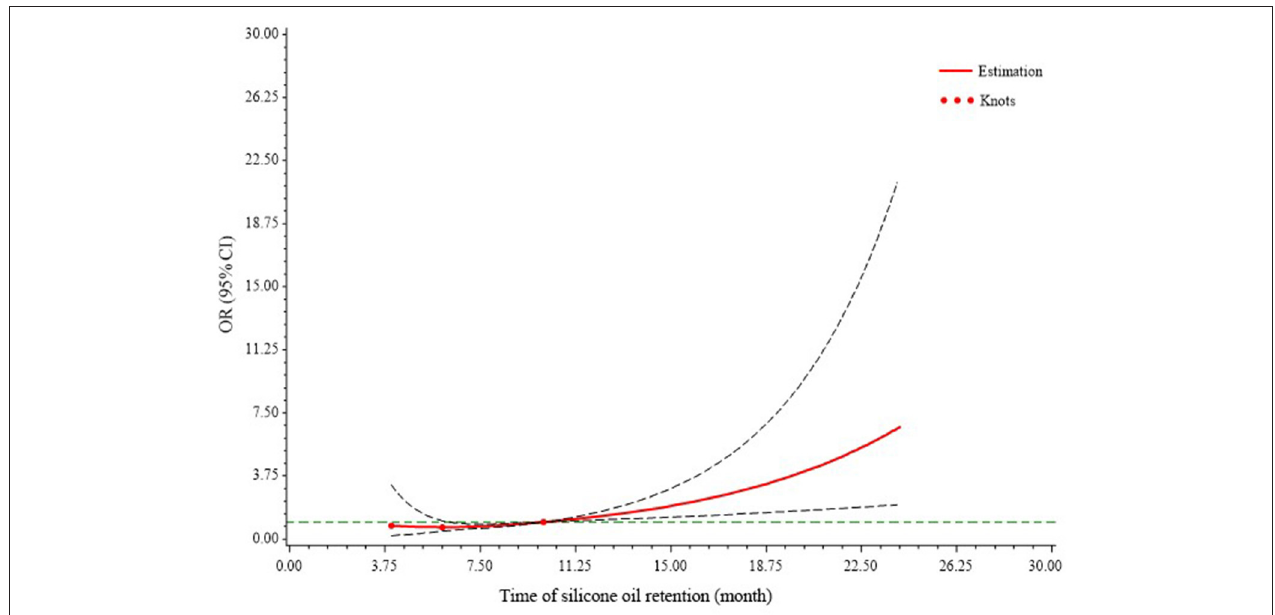
FIGURE 2 | Association between band keratopathy and silicone oil retention time. Restricted cubic splines with three knots at the 25th, 50th, and 75th centiles were used to model the association between band keratopathy and silicone oil retention time. This model was adjusted for intraocular pressure, sex, diagnosis, zone of injury, and iris status. The 95% confidence intervals are indicated by the black dashed lines. The risk of band keratopathy increases with time and remains almost stable within 6 months, increases slowly at 6–10 months, and increases sharply after 10 months postoperatively. CI, confidence interval; OR, odds